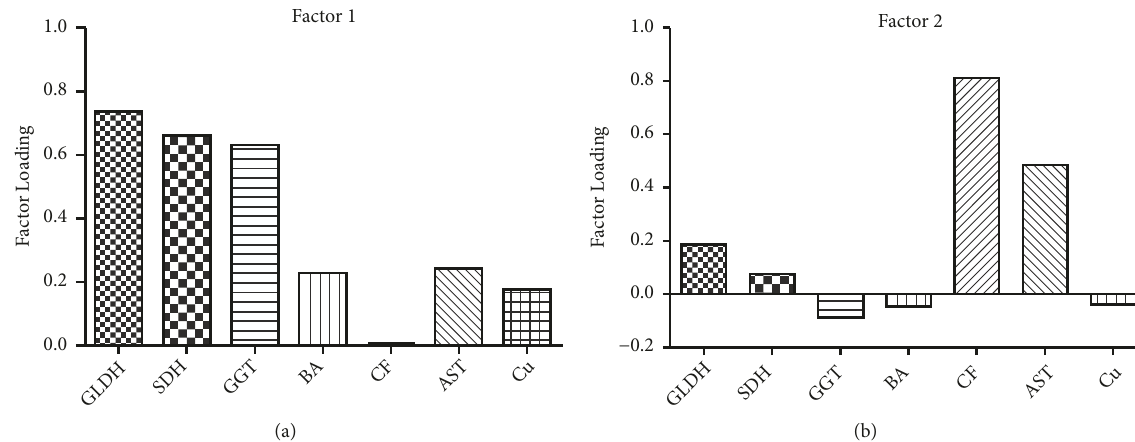
Figure 1: Factor analysis of liver-leakage enzymes, bile acids, and hepatic crude fat with an oblique rotation represented in graphic form (n=100).A moderateloading was considered tobe0.4-0.7and a strong loading was considered > 0.7-1.0,inabsolute values.Thelatentvariables are represented as (a) hepatocyte health factor and (b) hepatic lipidosis factor.